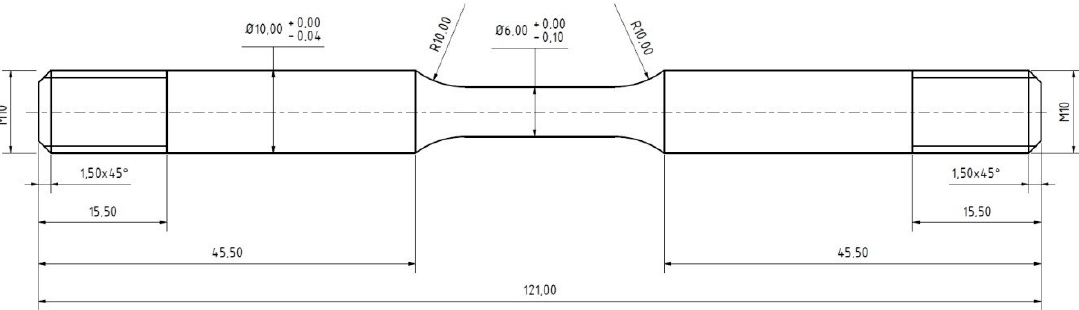
Figure 8. Samples used to measure mechanical properties as exposed in a vacuum furnace (unit: mm).